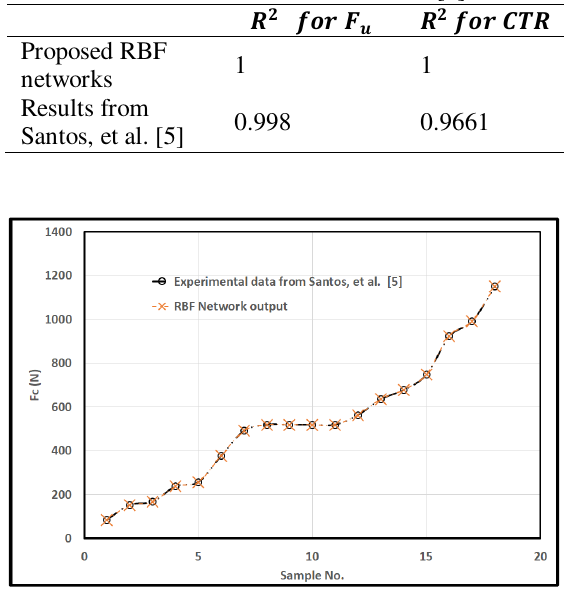
response against & (cid:29)